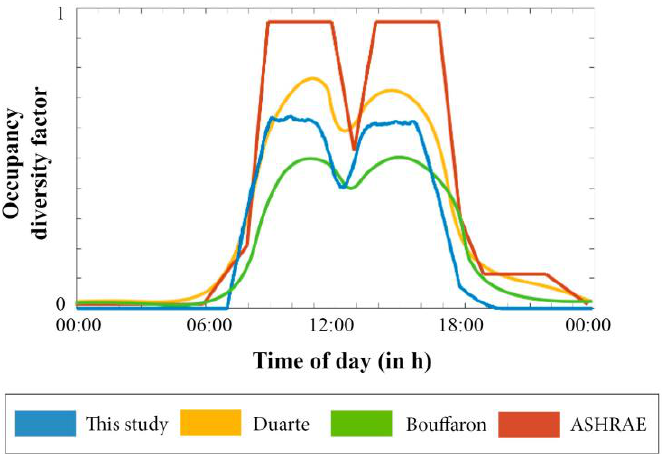
Figure 4. Occupancy diversity factors of the validation case simulated in this study and occupancy diversity factors of earlier studies.